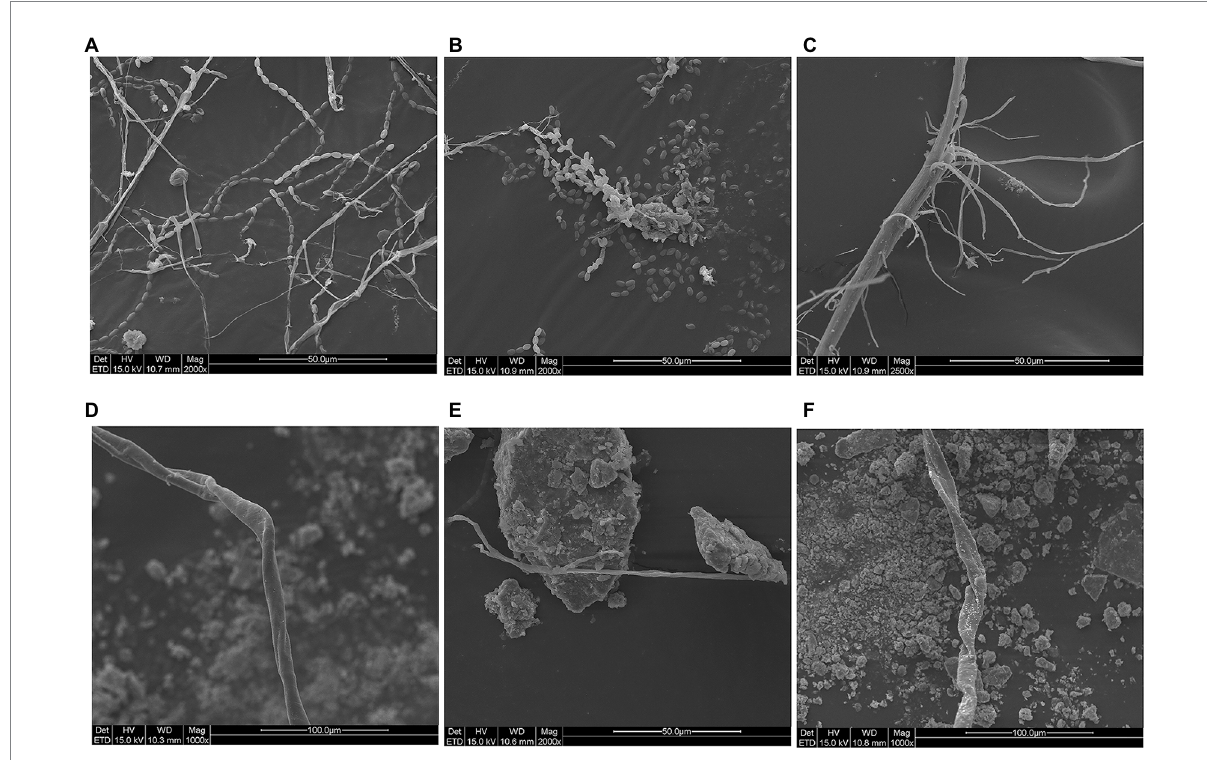
FIGURE 2 SEM results of spots. (A) Ear of pottery figurine TN61E65M47:3. (B) Face of pottery figurine TN61E65M47:3. (C) Left arm of pottery figurine TN61E65M47:3. (D) Face of pottery figurine TN61E65M47: 2. (E) Leg of pottery figurine TN61E65M47: 2. (F) Leg of pottery figurine TN61E65M47: